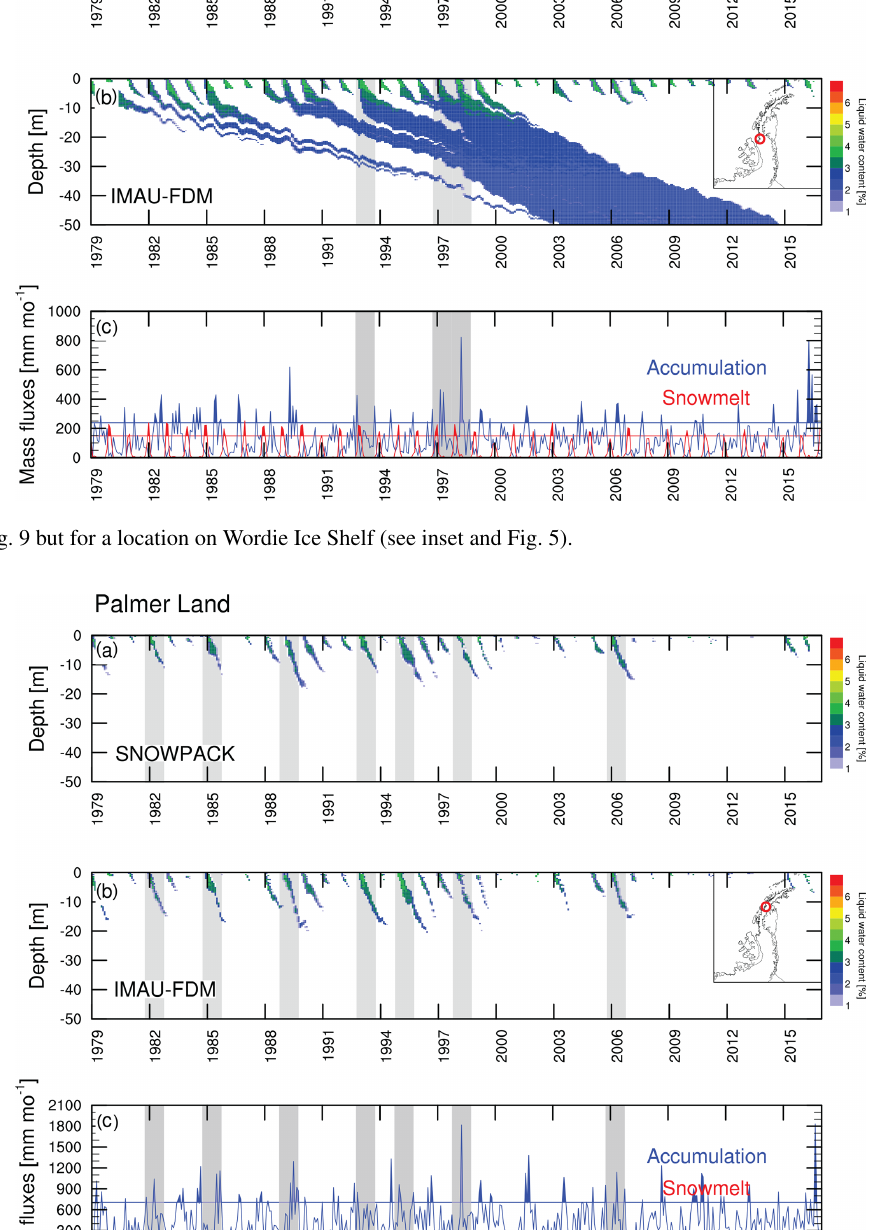
The Cryosphere, 15, 695–714, 2021